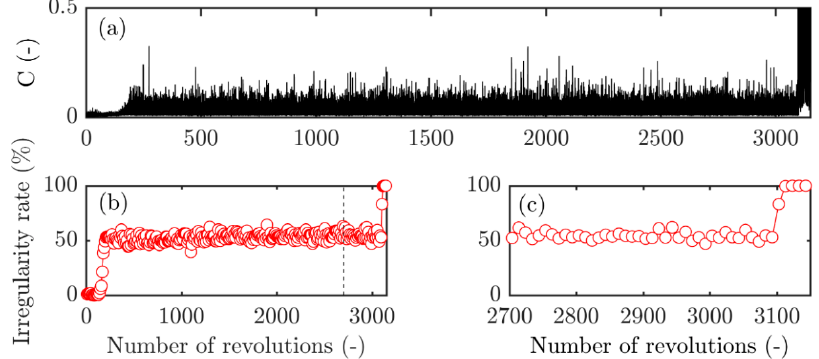
Figure 17. Correlation and irregularity rate evolution for a fixed operating point just before stall. ( a ) Correlation; ( b ) irregularity rate; ( c ) zoomed view of the irregularity rate. Sensor location: (x, θ ) = ( − 0.06C x , 90°).